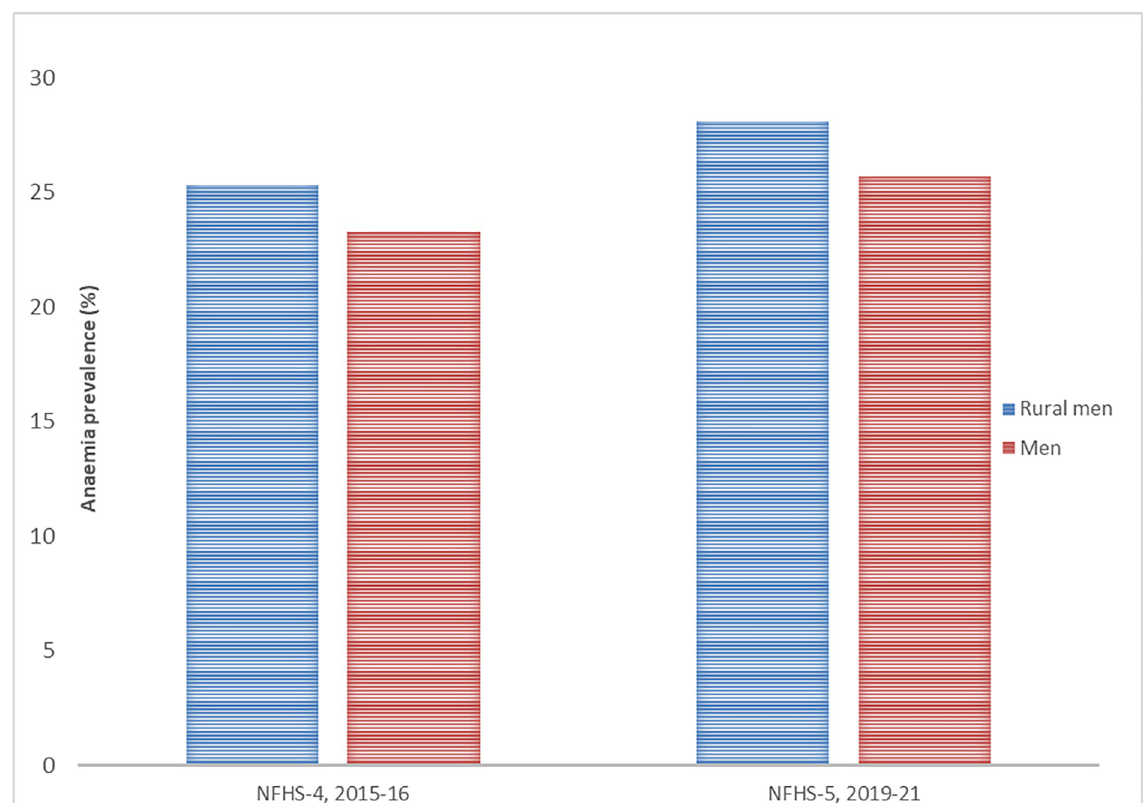
Fig 3. Trend of anaemia prevalence among rural men and men overall in India,